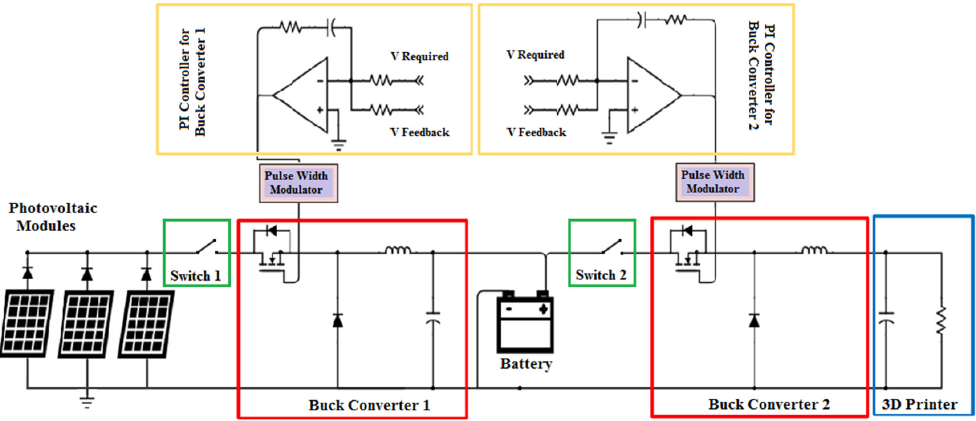
Figure 1. Schematic of power supply/battery charging stand-alone PV System for a MOST-delta RepRap 3-D printer for showing the arrangement of the PV modules, Buck converters, and the battery. The MOST Delta RepRap printer [10,30] is a conglomeration of four stepper motors controlled by a Melzi [31] motor drive controller based on the Arduino architecture and a resistively-heated hot end with temperature feedback and position feedback from end stop mechanical switches, as seen in Figure 2.